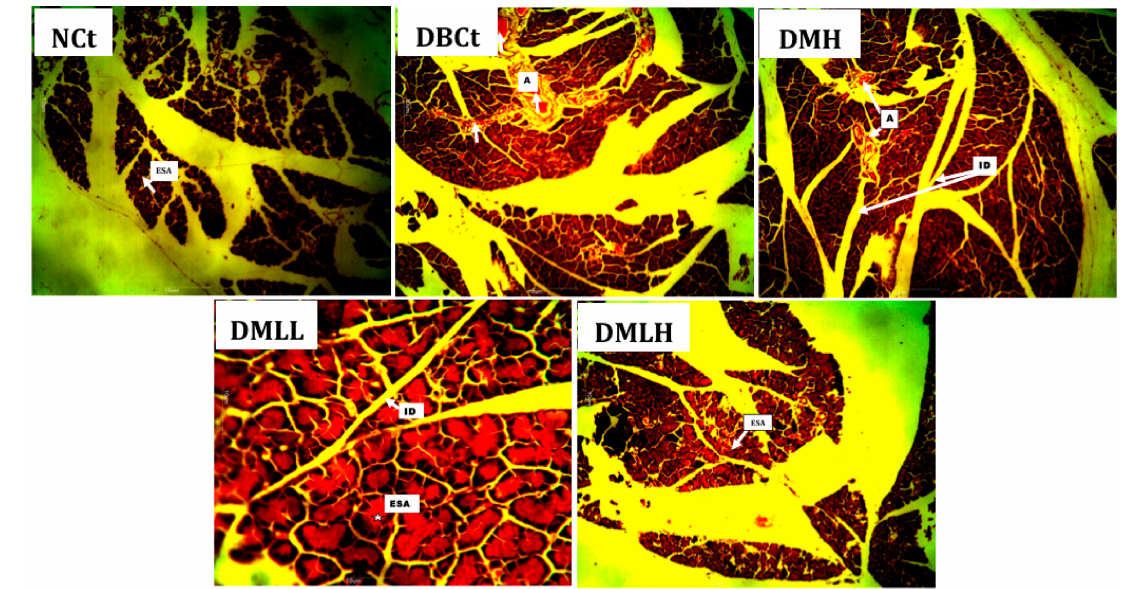
Figure 5. Photomicrograph of the histopathological evaluation of the experimental animals’ pancreatic tissues after the experimental period elapsed.